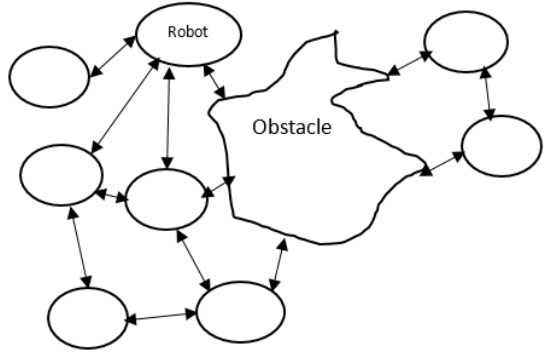
Figure 13. Example of the interaction between robots and obstacles.